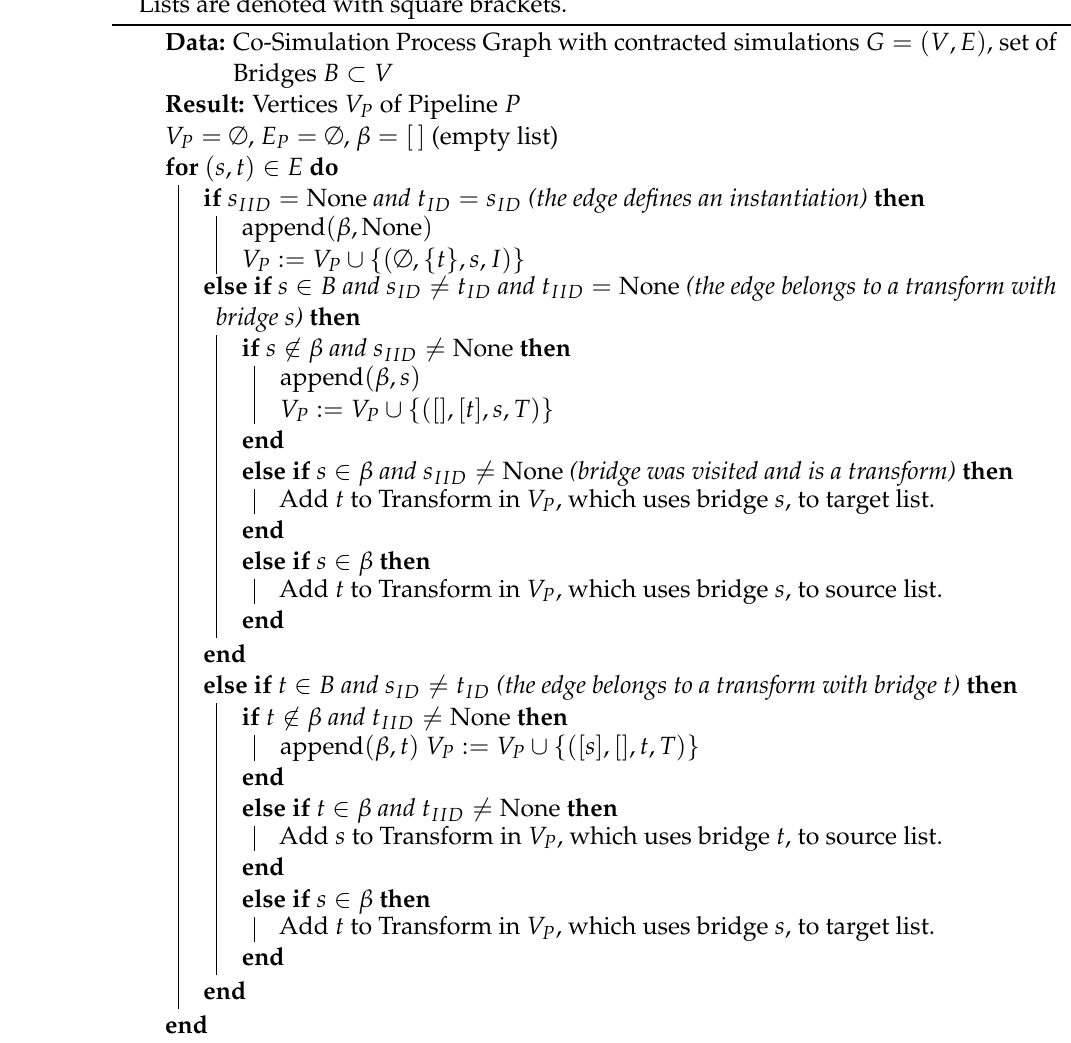
Algorithm 1: Creating the vertices of a pipeline from an extended pipeline graph. Lists are denoted with square